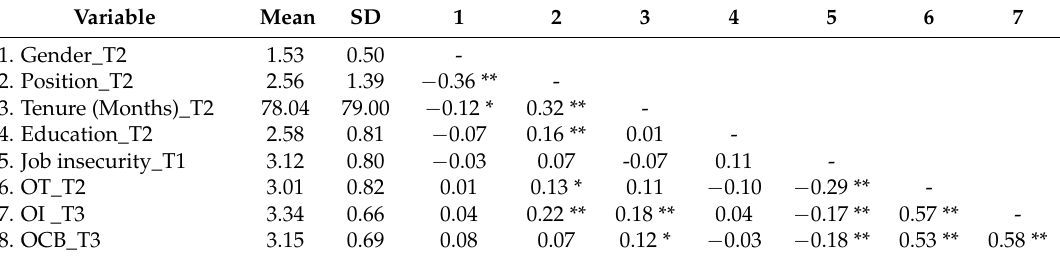
Table 2. The means, standard deviations, and correlations between the